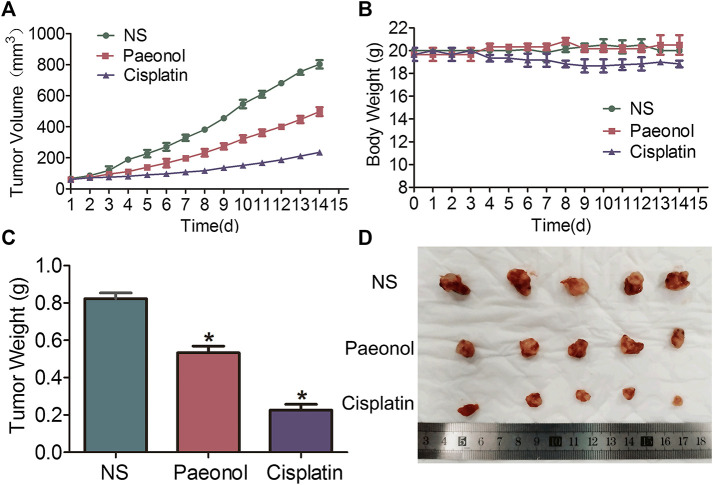
Paeonol exerts anti-tumor effects on A549 cells transplanted tumors in nude mice treated with paeonol or cisplatin. (A) Tumor growth curve of A549 cells. (B) Body weights. (C) Tumor weights. (D) Morphological image of the tumors. Significance: *p < 0.05 vs. NS, n = 5.